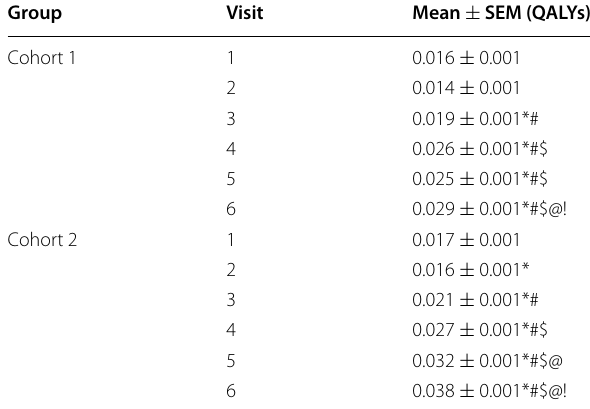
* P < 0.05, compared to V1 of respective group, #compared to V2 of respective group, $compared to V3 of respective group, @compared to V4 of respective group, !compared to V5 of respective group. Data presented as mean Data analyzed by two-way ANOVA followed by Tukey’s multiple comparison test ( CI 95%, P < 0.05) =